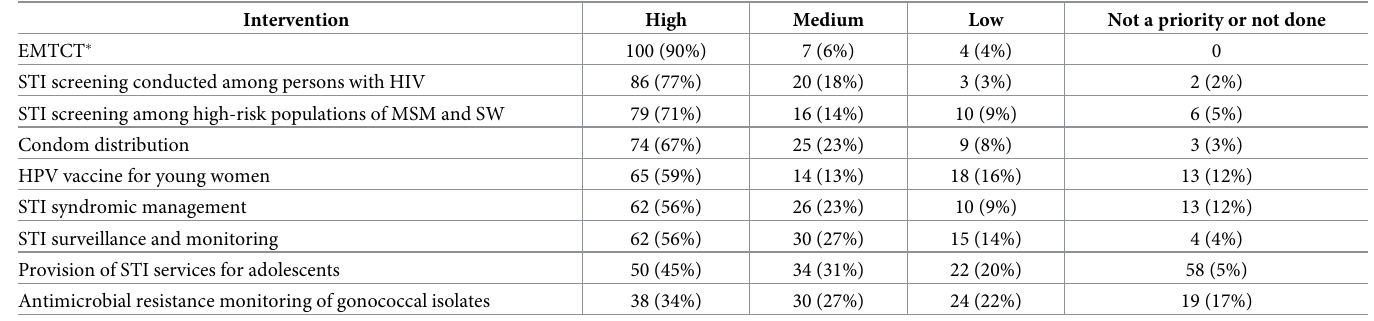
Table 3. Country prioritization of STI interventions (N =